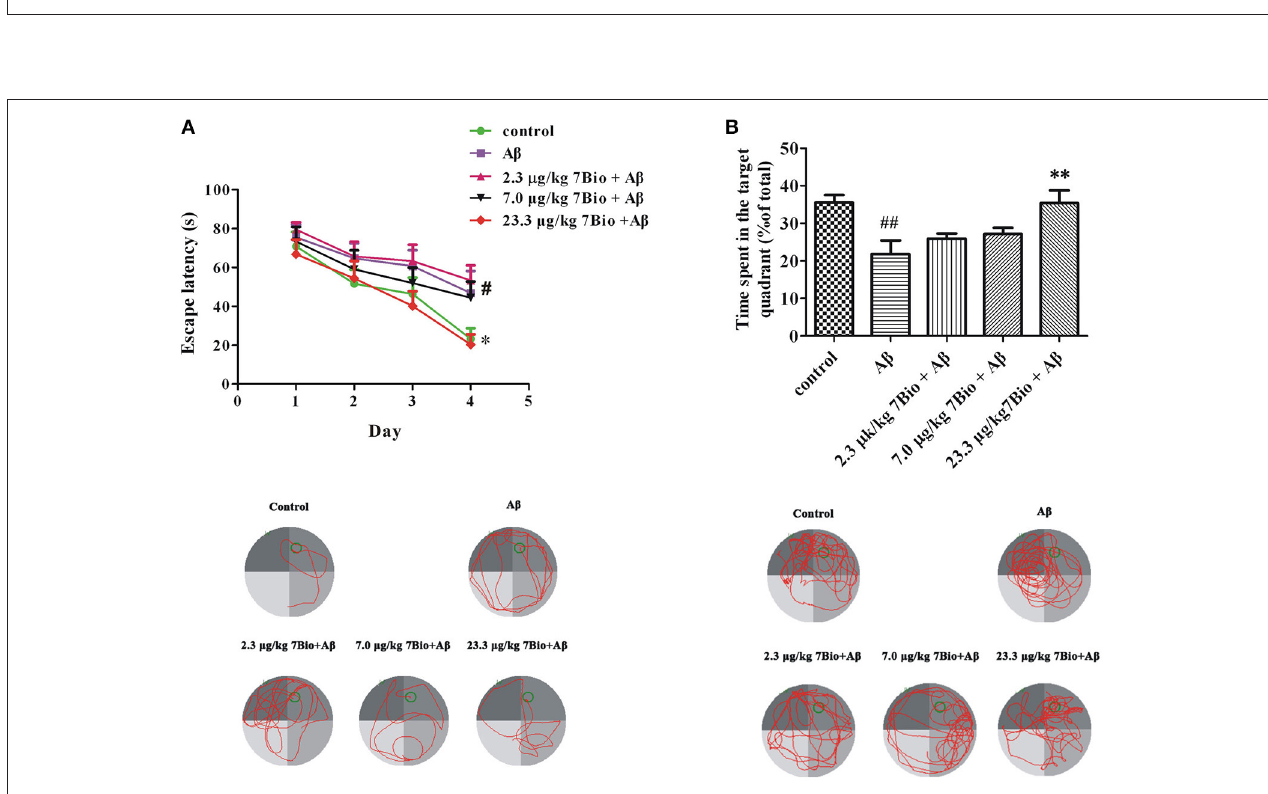
FIGURE 6 | 7Bio attenuates A β oligomer-induced impairments of spatial learning and memory in mice. (A) During the 4 days of training session, 7Bio at 23.3 µ g/kg significantly reduced the escape latency of A β oligomer-treated mice to find the hidden platform in the Morris water maze test. Lower part: representative tracking paths of various groups as indicated in the last day of training session. (B) In the probe trial, 7Bio at 23.3 µ g/kg significantly attenuated the decreased duration of A β oligomer-treated mice in the target quadrant in the Morris water maze test. Lower part: representative tracking paths of various groups as indicated in the probe trial. Data represent the mean ± SD ( n = 10); # p < 0.05 and ## p < 0.01 vs. the control group; * p < 0.05 and ** p < 0.01 vs. the A β group (one-way ANOVA and Tukey’s test).